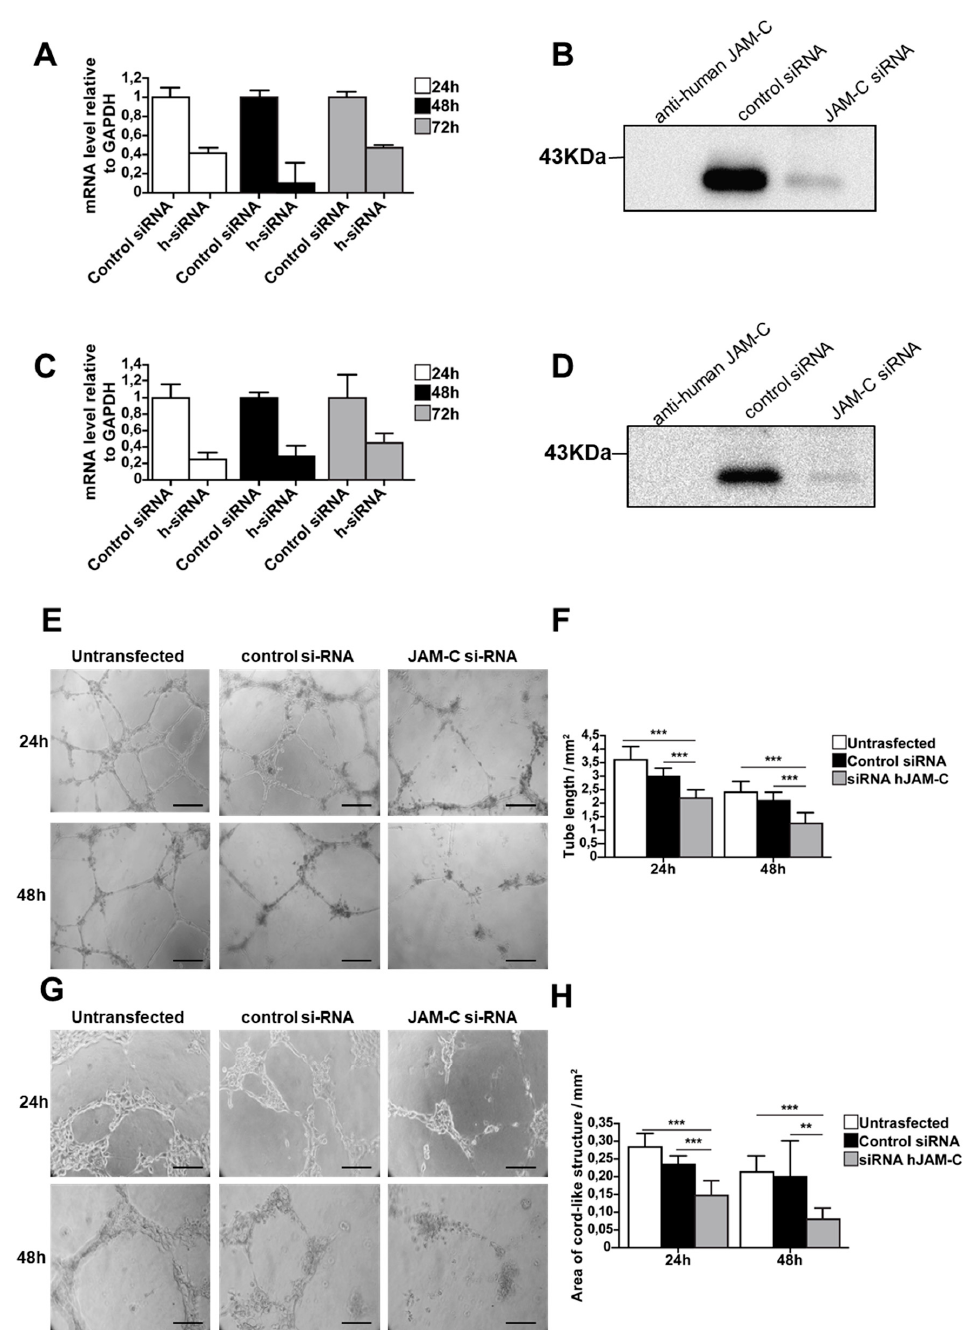
Figure 4. Knockdown of JAM-C reduced in vitro cord-like structures on Matrigel TM . ( A ) The mRNA expression levels of human JAM-C in HUVECs transfected with siRNA against JAM-C or with control siRNA isolated at 24, 48 and 72 h after transfection. The 48 h time point showed the strongest knockdown of JAM-C m-RNA levels. Data are represented by mean ± SD ( n = 3). ( B ) The protein expression level of human JAM-C was analyzed by Western blot in HUVECs transfected with siRNA against JAM-C or with control siRNA, showing a strong decrease in total cellular JAM-C protein levels. Cell surface biotinylation, lysis and JAM-C precipitation were performed 72 h after transfection. Cell lysates from HUVECs transfected with control siRNA or JAM-C siRNA were probed with anti-human JAM-C polyclonal antibody. Equivalent amounts of protein were loaded. As an internal control, anti-human JAM-C was loaded alone. ( C ) The mRNA expression levels of mouse JAM-C showed that JAM-C siRNA treatment decreased JAM-C mRNA levels. ( D ) The protein expression levels of